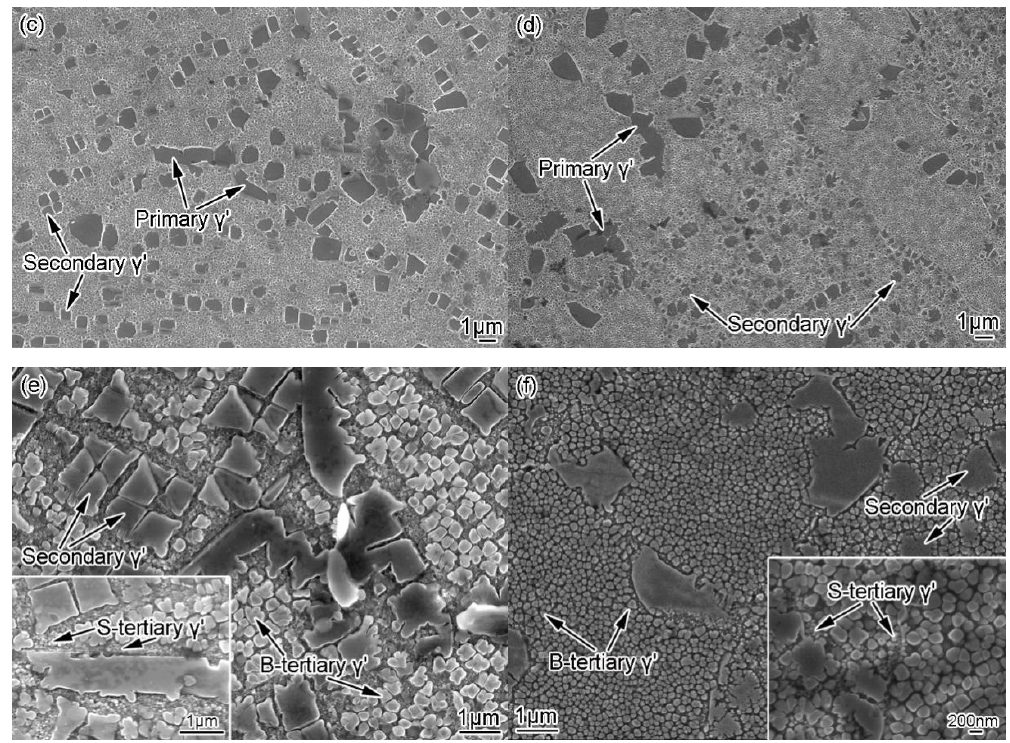
Figure 3. Initial microstructures of FGH100L alloy before creep: ( a ) optical microscopy (OM) images of HIPed alloy, ( b ) OM images of IFed alloy, ( c , e ) SEM images of HIPed alloy, and ( d , f ) SEM images of IFed alloy.